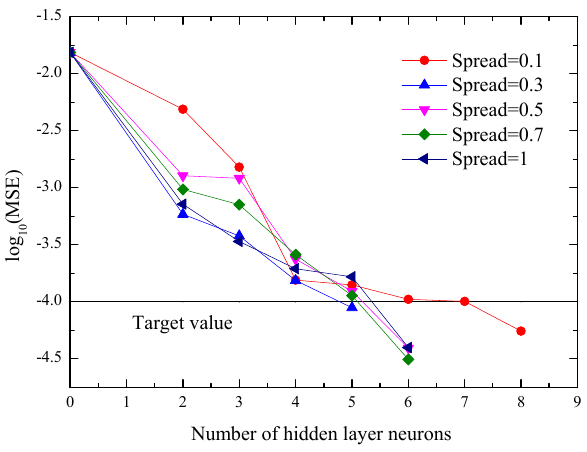
Figure 13. Relationships of mean square error (MSE) and the number of hidden layer neurons with different values of Spread. Table 3. Performance evaluation of the RBF neural network for the total samples with different values of